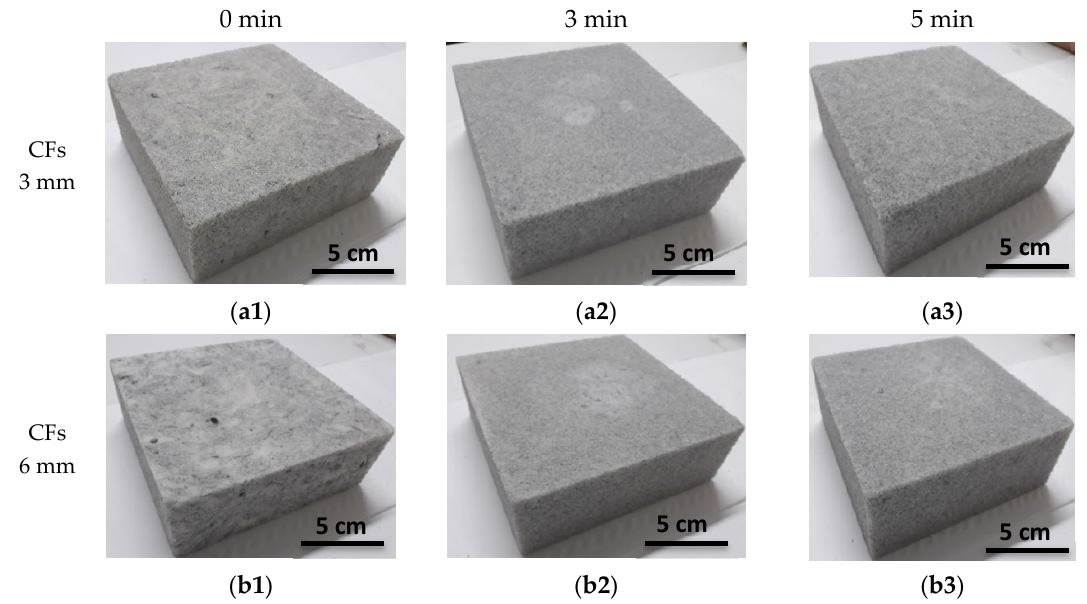
Figure 7. Epoxy foam loaded with 0.5 wt.% of ( a ) 3 mm-CFs and ( b ) 6 mm-CFs prepared with shear mixing for ( 1 ) 0 min, ( 2 ) 3 min, and ( 3 ) 5 min.